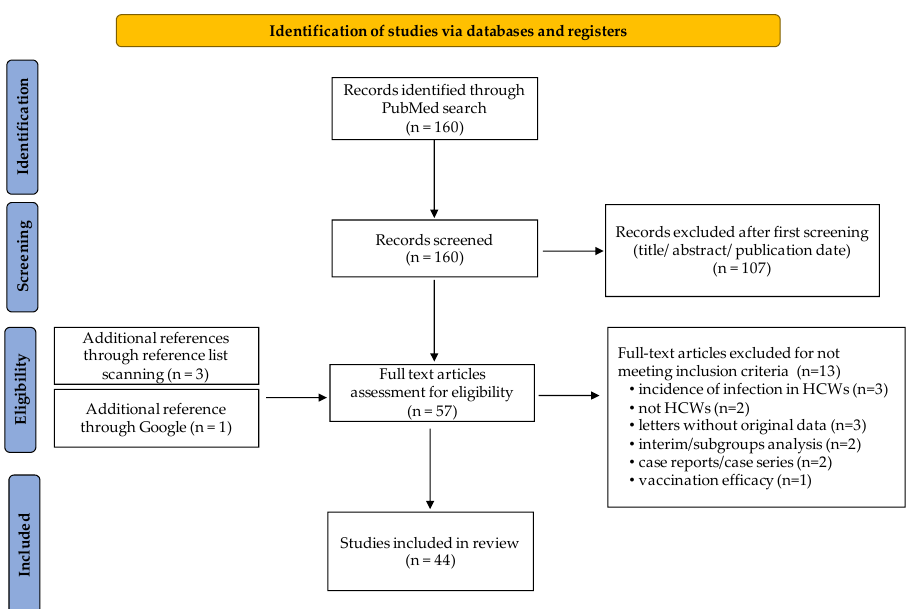
Figure 1. Review’s flow diagram. Study selection strategy.